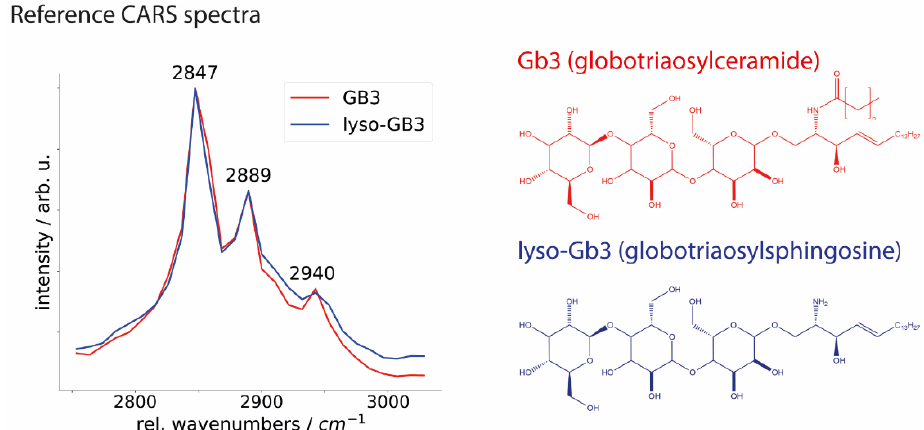
Figure 6. Reference spectra of globotriaosylceramide (Gb3, depicted in red) and its metabolite globotriaosylsphingosine (lyso-Gb3, depicted in blue) were recorded using a CARS microscope. The chemical structures of Gb3 and lyso-Gb3 are displayed in their respective colors. Relative (rel.) wavenumbers correspond to the measured compared to the laser baseline (785 nm) wavenumber.